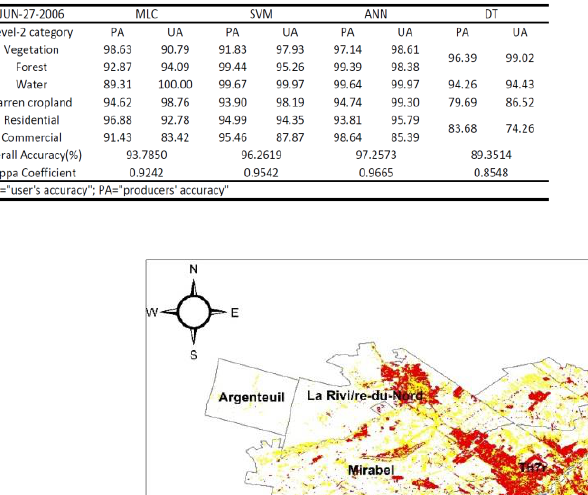
Table 4 . Accuracy assessment comparison among different classifiers for the 2006 imagery